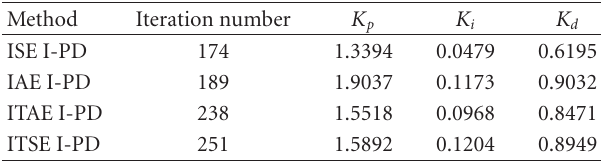
Table 3: Optimised K p , K i , and K d values for Example 2.